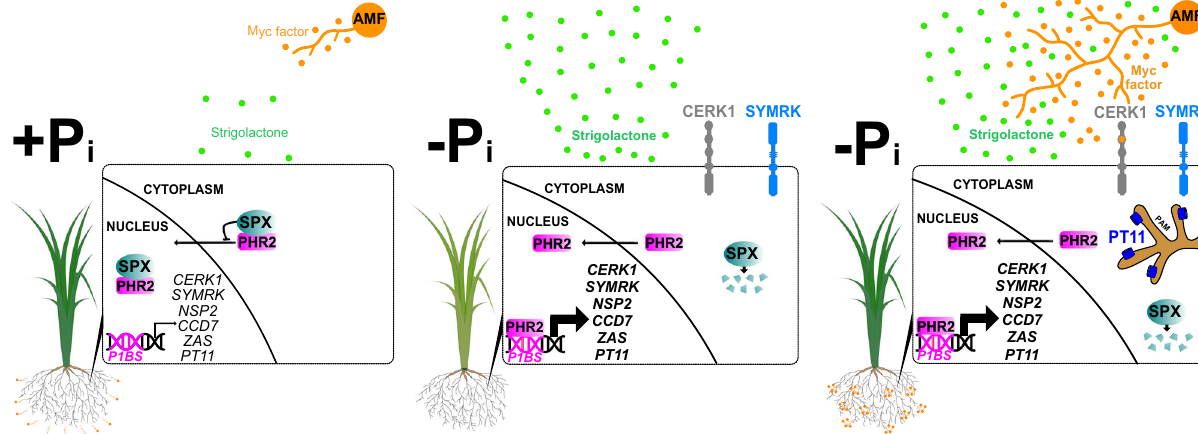
Fig. 6 Model depicting regulation of AM symbiosis by PHR2. When plants obtain suf fi cient phosphate (left), SPX proteins prevent nuclear translocation of PHR2 42 , as well as PHR2 binding to promoters of phosphate starvation -induced genes including AM relevant genes 17,42 . This causes low exudation of strigolactone and poor expression of genes required for perception of Myc-Factors and fungal entry, thereby preventing full symbiosis development. Upon phosphate starvation, SPX proteins, are degraded 42 . Consequently, PHR2 is active, can bind to P1BS elements in promoters, and transcriptionally activate genes important for AM, such as CCD7 involved in strigolactone biosynthesis for activation of the fungus in the rhizosphere prior to contact 31 – 33 , genes encoding receptors involved in the perception of fungal signals prior to root contact such as CERK1 and SYMRK 39,40,65,66 , the transcription factor NSP2 67 , ZAS involved in apocarotenoid biosynthesis promoting root colonization 68 , and the AM-speci fi c phosphate transporter gene PT11 41 (localized to the peri- arbuscular membrane (PAM)) required for Pi uptake from the fungus. (For simplicity, we focus here on 6 genes with important and genetically determined roles in AM that have been recovered in both ChIP-Seq replicates Fig. 3C, and were con fi rmed by ChIP-qPCR, Supplementary Fig. 17). Consequently, at low phosphate, roots exude increased amounts of strigolactone and can perceive fungal signals (middle), the fungus is activated to colonize the roots and the symbiosis can function through nutrient transporters localizing to the peri-arbuscular membrane (right). Thus, symbiosis establishment appears to be enabled as a part of the PHR2-regulated phosphate starvation